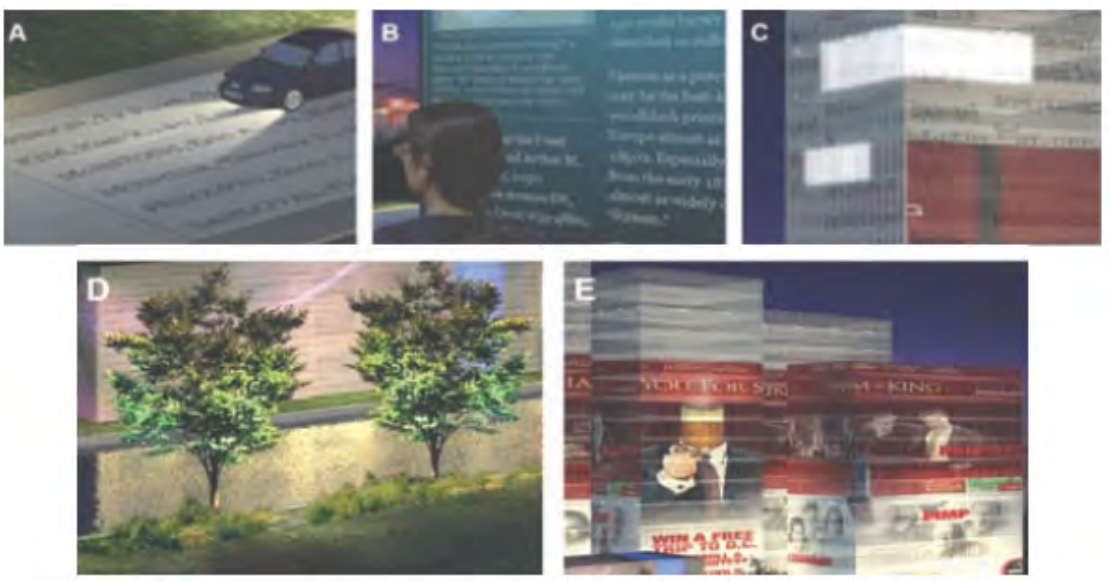
Figure 2. Factors affecting the location of media content on certain